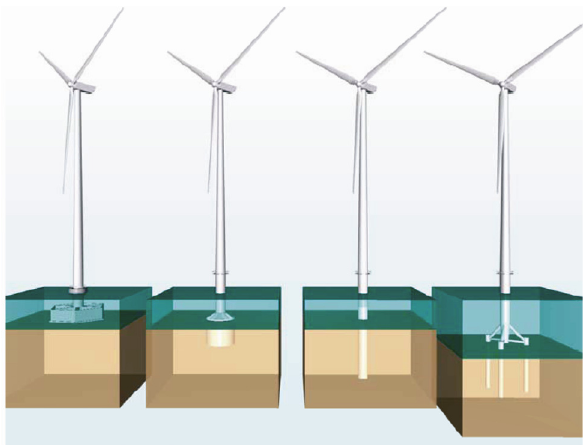
Fig. 1. Offshore foundations employed in wind turbine const- ruction, from left to right: a) gravity foundation; b) bucket foundation; c) monopole foundation; d) tripod